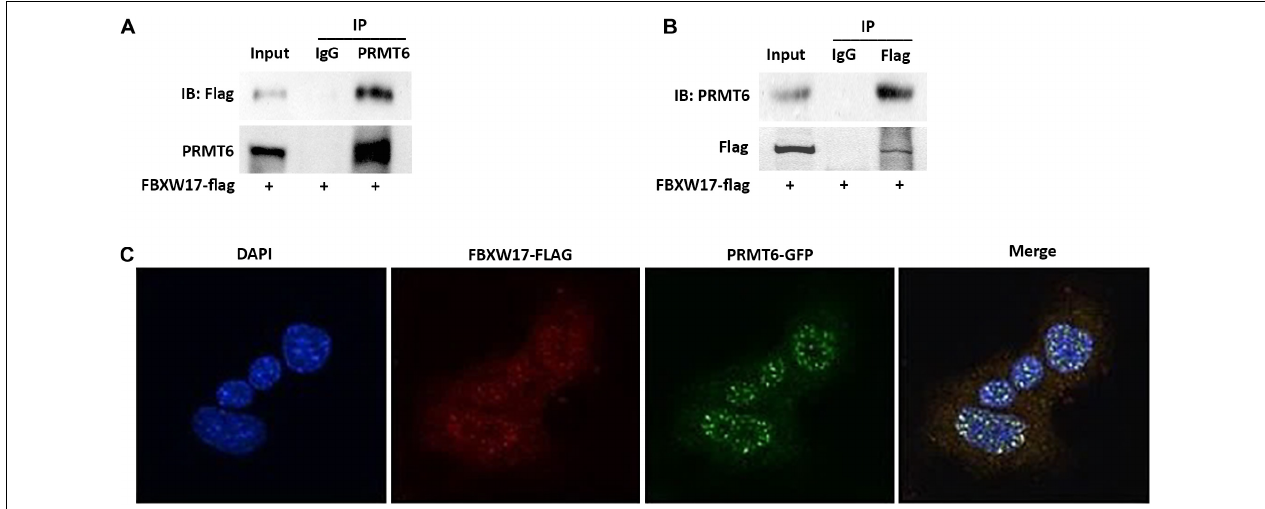
FIGURE 4 | FBXW17 interacting with protein arginine N-methyltransferase 6 (PRMT6) colocalize in the nucleus. (A) WT FBXW17-FLAG plasmids were delivered into MLE12 cells for 48 h. After transfection, cell lysate was immunoprecipitated with PRMT6 antibody. Then, the immunoprecipitants were analyzed with FLAG and PRMT6 immunoblotting. (B) One microgram of cell lysate was subjected to FLAG immunoprecipitation. Immunoblotting analyses used PRMT6 antibody. (C) FBXW17-FLAG plasmid (red) and PRMT6-GFP plasmid (green) were cotransfected into MLE12 cells. 4 (cid:48) ,6-Diamidino-2-phenylindole (DAPI) was used to dye the nucleus. Cells were subjected to fluorescence microscopy with different wavelengths of light. Images were merged under a confocal microscope. Results are shown with a representative of n = 3 experiments.